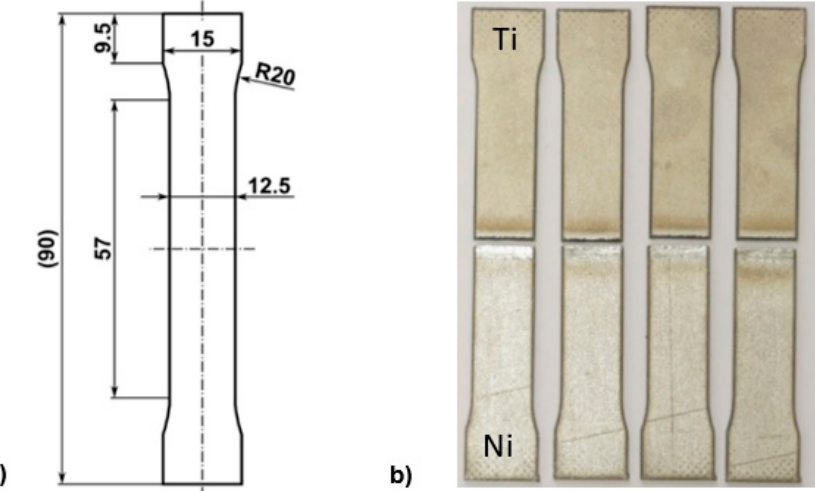
Figure 3. The tensile test specimens’ schematic ( a ), and fractured test specimens after tensile testing ( b ).